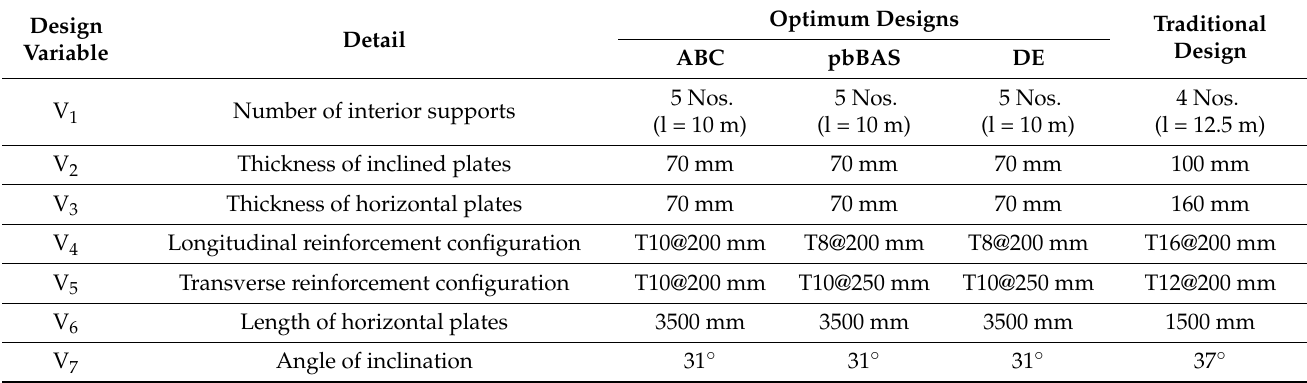
Table 24. The best optimum values of folded plate variables obtained by each metaheuristic algorithm for the three-segment type folded plate roof building.